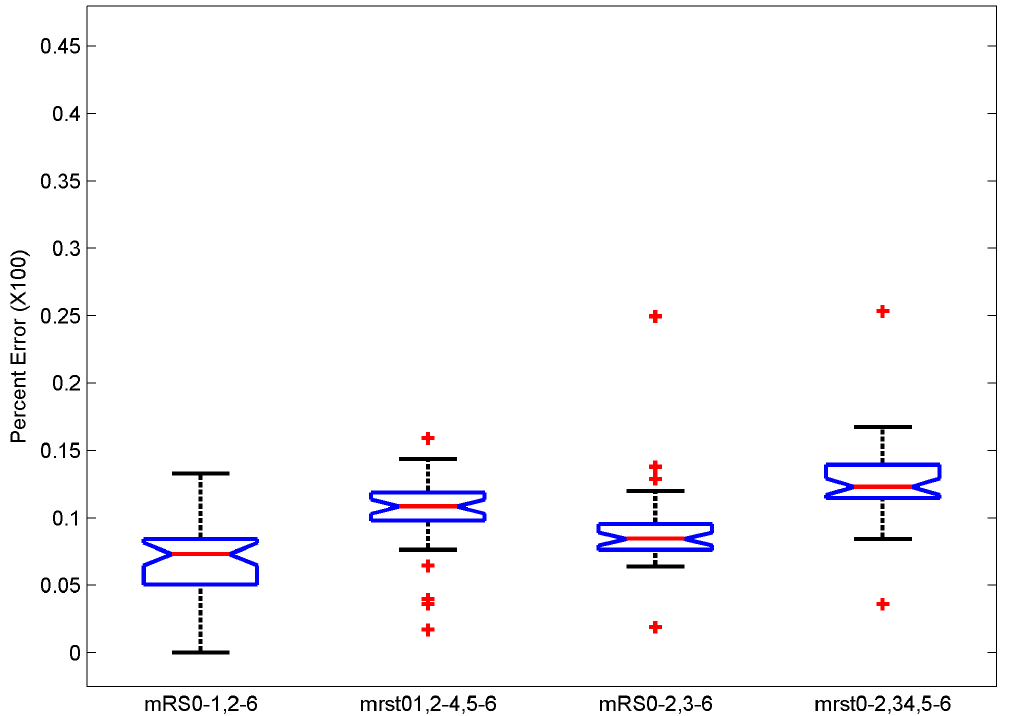
Figure 3. Box plots of error rates for dichotomizing at cut-point of mRS 1 (mRS 0–1, 2–6), trichotomizing at cut-points 1 and 4 (mRS 0–1, 2–4, 5–6), dichotomizing at mRS 2 (mRS 0–2, 3–6), and trichotomizing at cut-points 2 and 4 (mRS 0–2, 3–4, 5–6). van Swieten’s inter-rater reliability matrix used as confusion matrix. Post-hoc testing shows that both trichotomization errors are higher than dichotomization (p , .05).